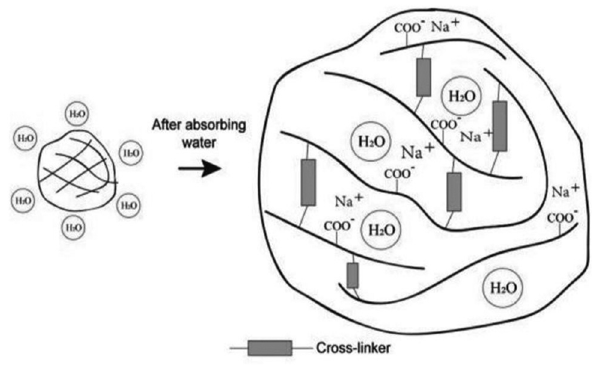
Figure 2: SAP reactions with water [ 28 ]